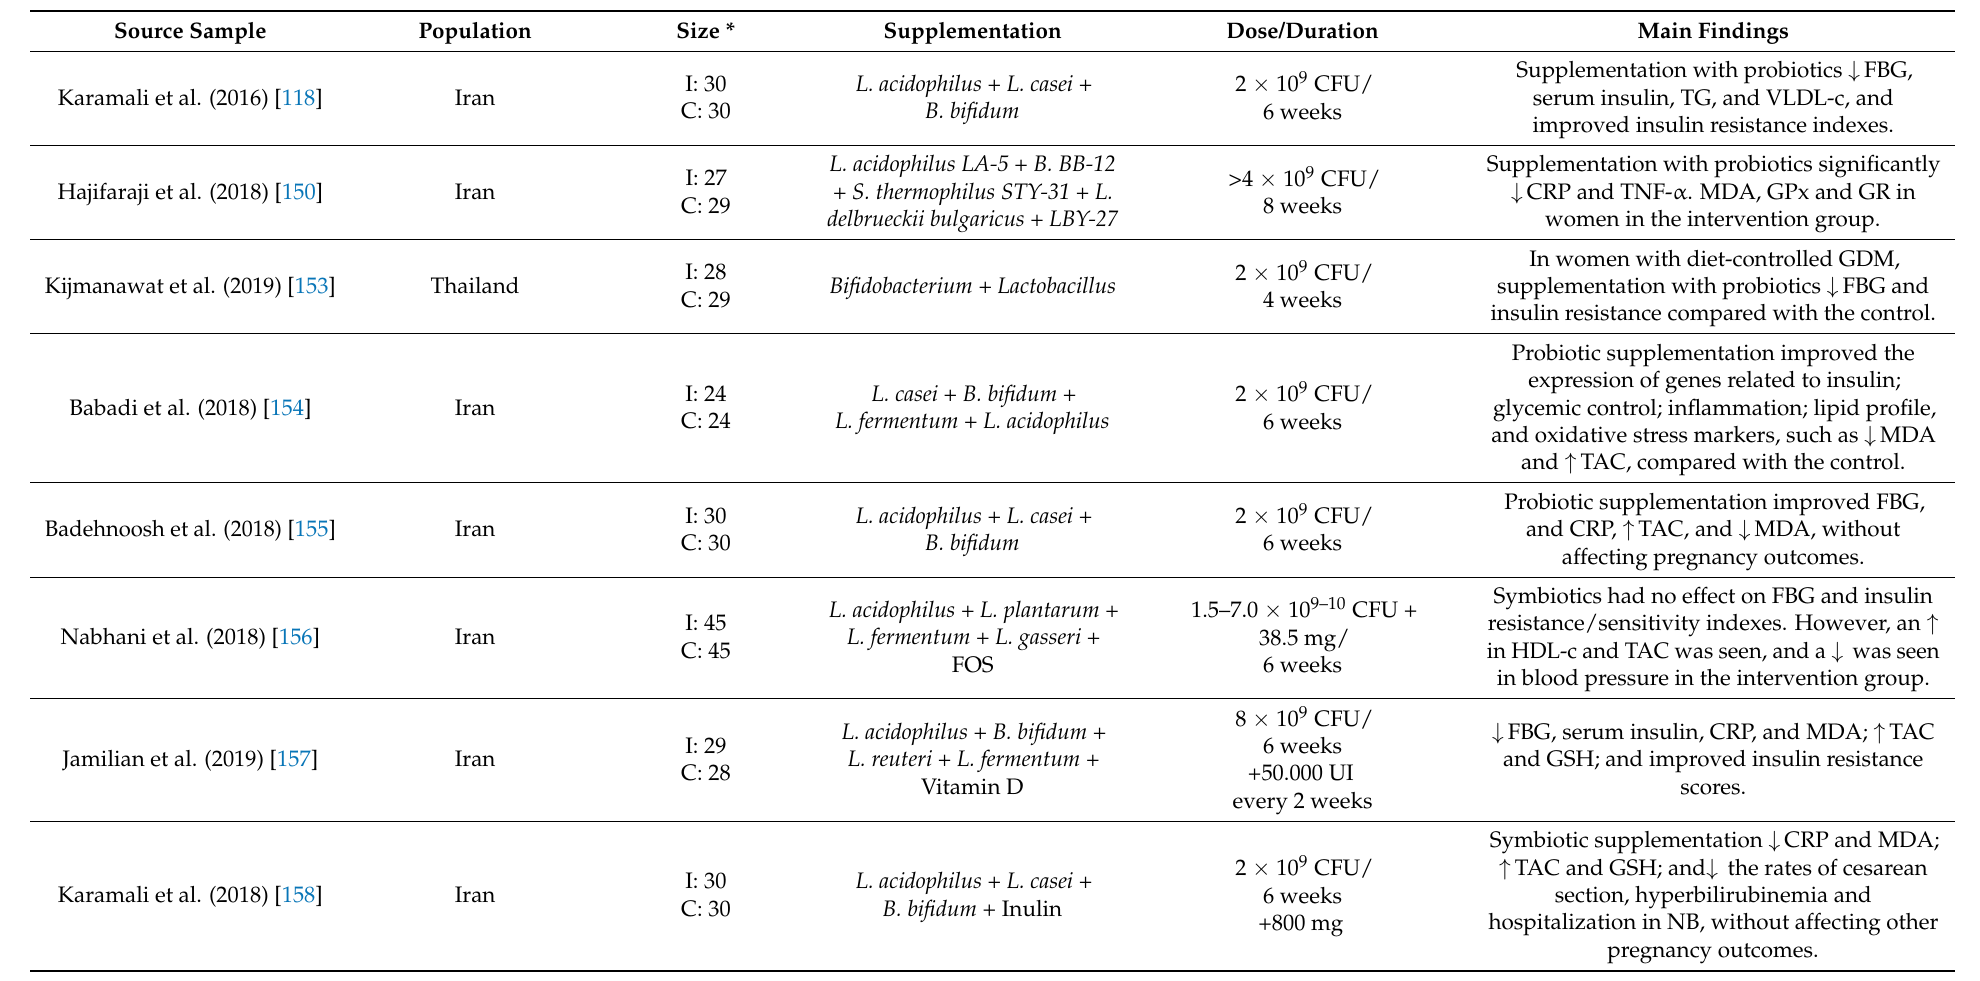
Table 1. Randomized clinical trials with supplementation of probiotics, alone or in combination, for the treatment of gestational diabetes